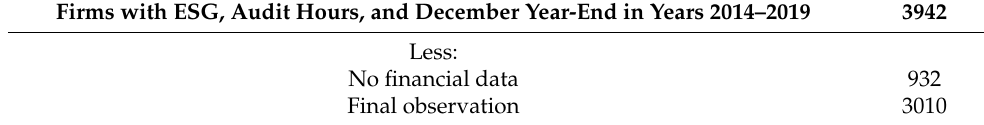
Table 1. The data selection process.